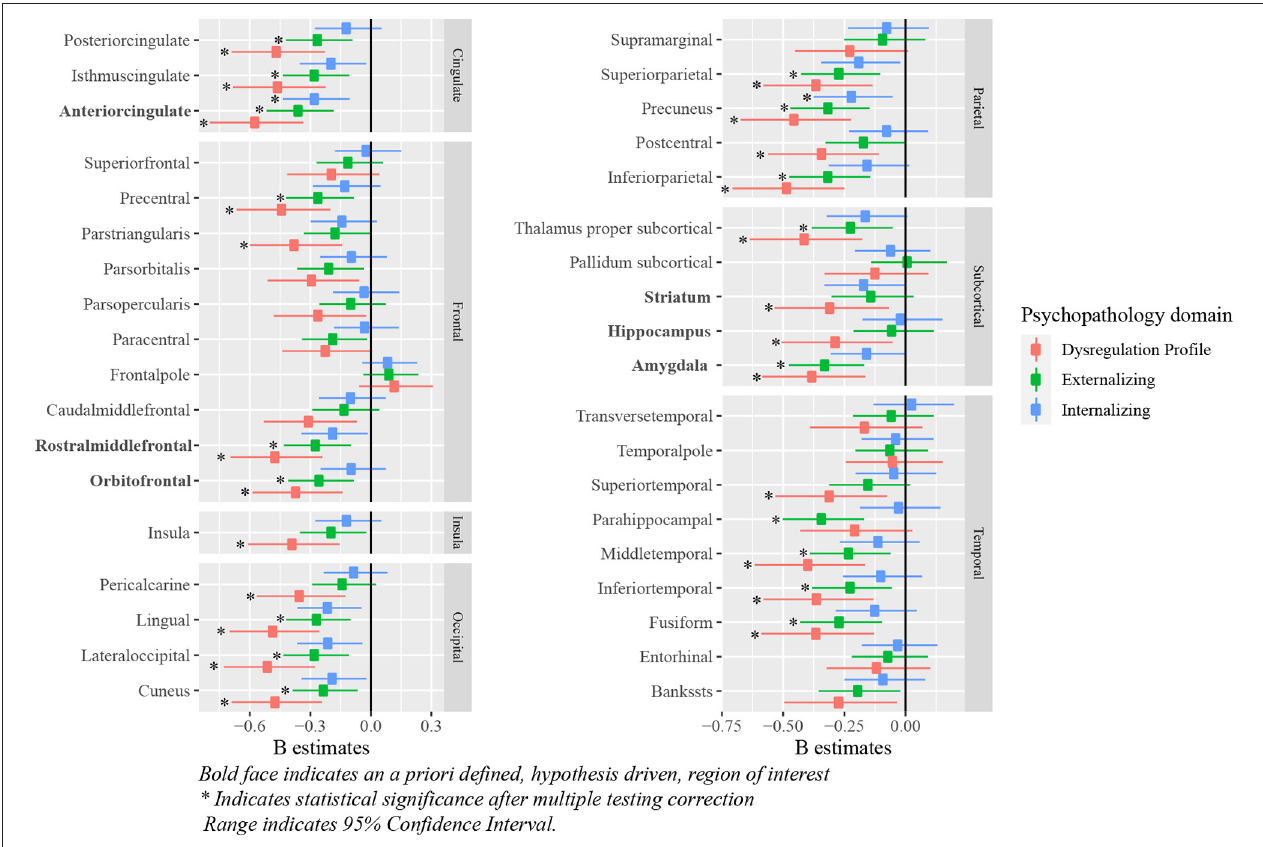
FIGURE 5 | Standardized B estimates of the relationship between z-scores (representing deviations of typical development in (sub-)cortical volume) and psychopathology symptoms. Bold face indicates an a priori defined, hypothesis driven, region of interest *indicates statistical significance after multiple testing correction range indicates 95% confidence